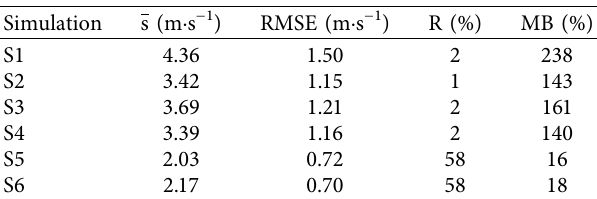
Table 7: Statistics of model to measurements comparison for hourly wind speeds during the simulated two days. The measured mean is 1.99 ms − 1 .